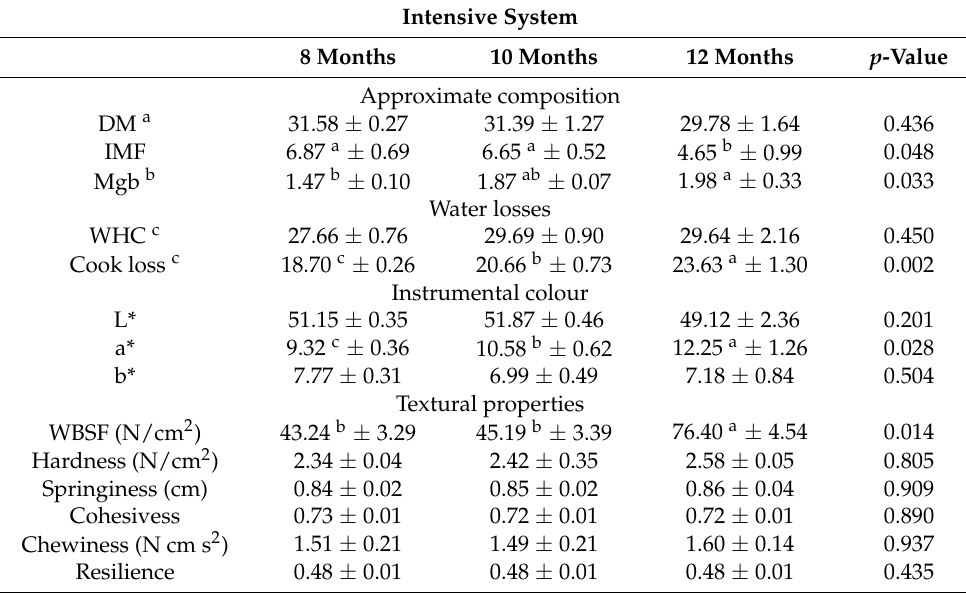
Table 6. Quality traits measured in fresh loins (m. Longissimus thoracis ) from Iberian × Duroc crossed animals reared under the intensive system according to slaughter